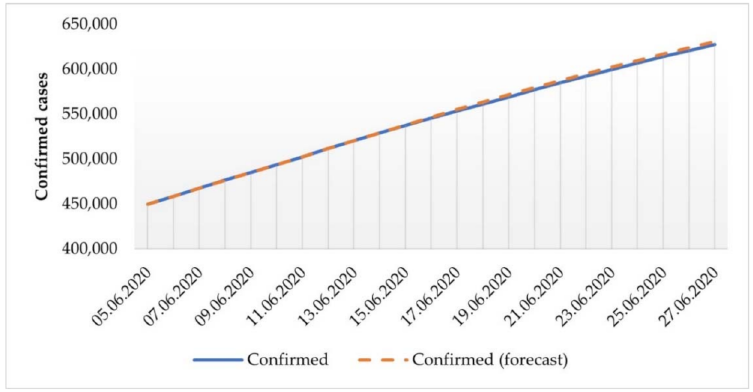
Figure 2. Dynamics of the total number of C ( t ) , the actual and predicted trajectories. The dynamics of the function ϑ ( t ) for the period under consideration are shown in Figure